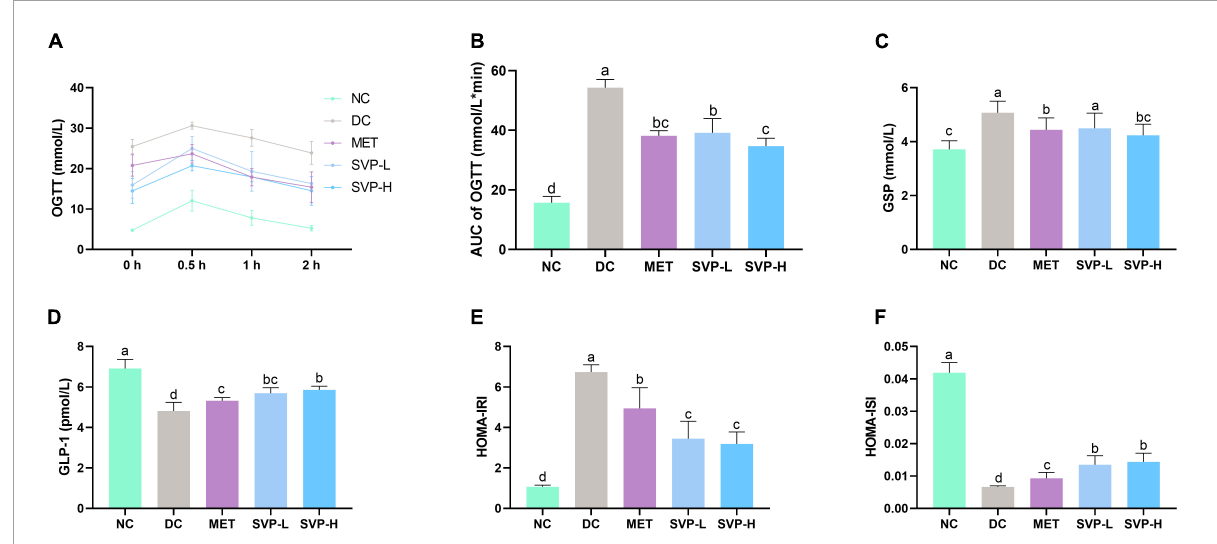
FIGURE3 Effects of oral SVP on the glucose tolerance and islet function-related indexes in T2DM mice. (A) Oral glucose tolerance test levels; (B) area under the curve values of oral glucose tolerance test; (C) glycated serum protein levels; (D) glucagon-like peptide-1 levels; (E) HOMA-insulin resistance index levels; (F) HOMA-insulin sensitivity index levels. Different superscript letters indicate statistically significant differences between the groups ( p <